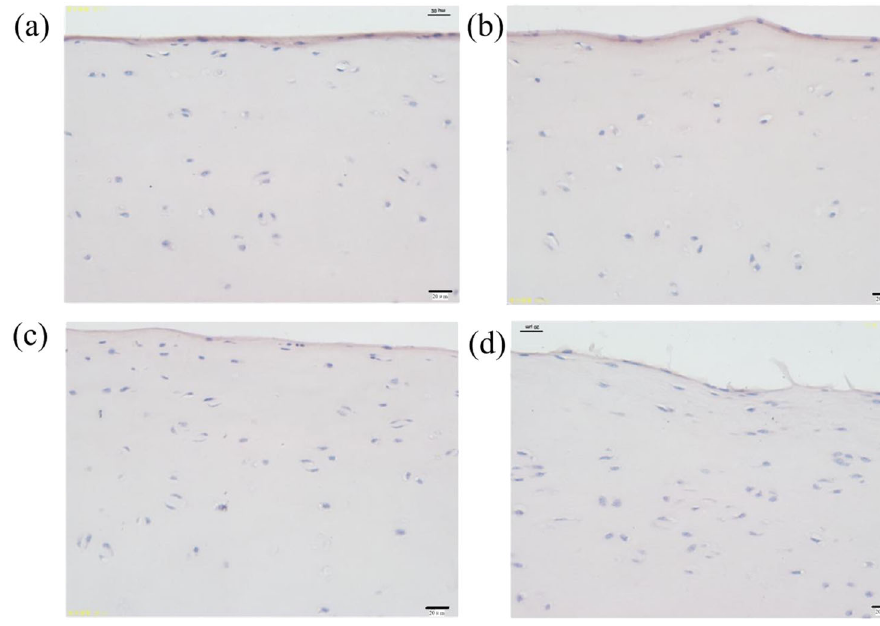
Fig. 3 HE staining morphology of articular cartilage at different times in vitro. a Fresh bovine cartilage; b 37 °C incubator for 1 h; c 37 °C incubator for 2 h;